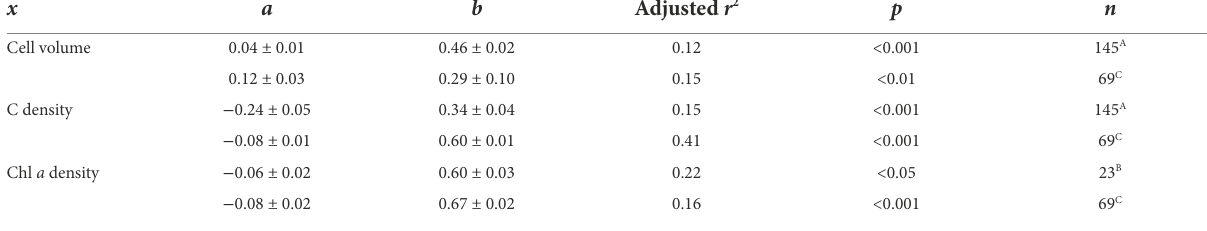
TABLE 3 Linear regression of F v / F m and each Log 10 transformed physiological parameter (i.e., cell volume, C density, and Chl a